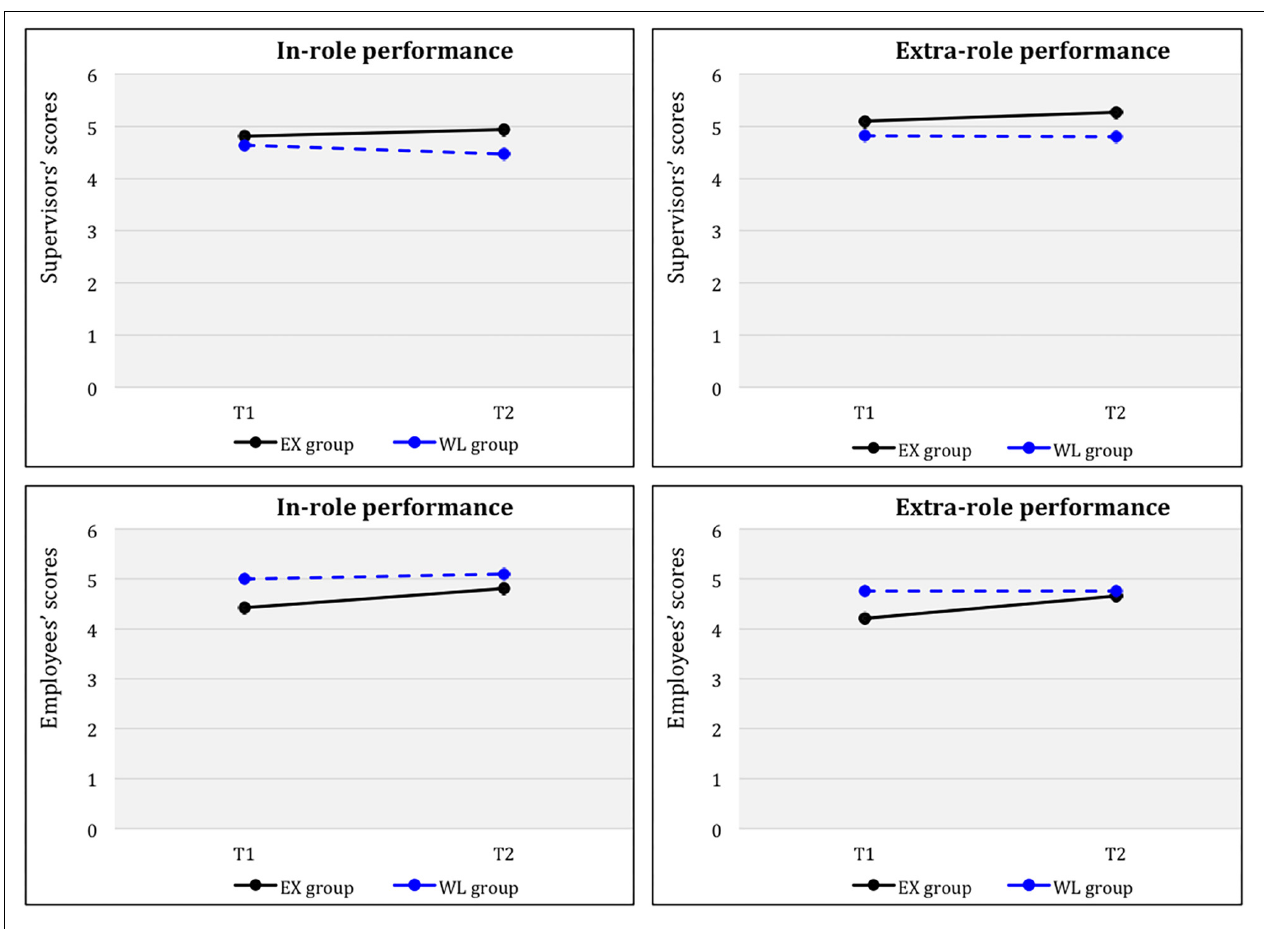
FIGURE 5 | In-role and extra-role performance for groups (EX, WL) across time (Tl, T2). TABLE 5 | T1 and T2 means and standard deviations (SD) for the EX and the